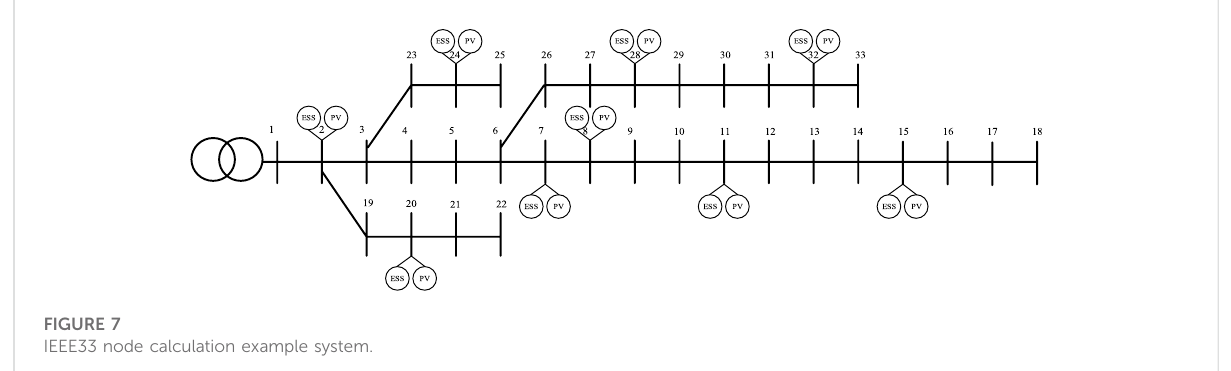
FIGURE 7 IEEE33 node calculation example